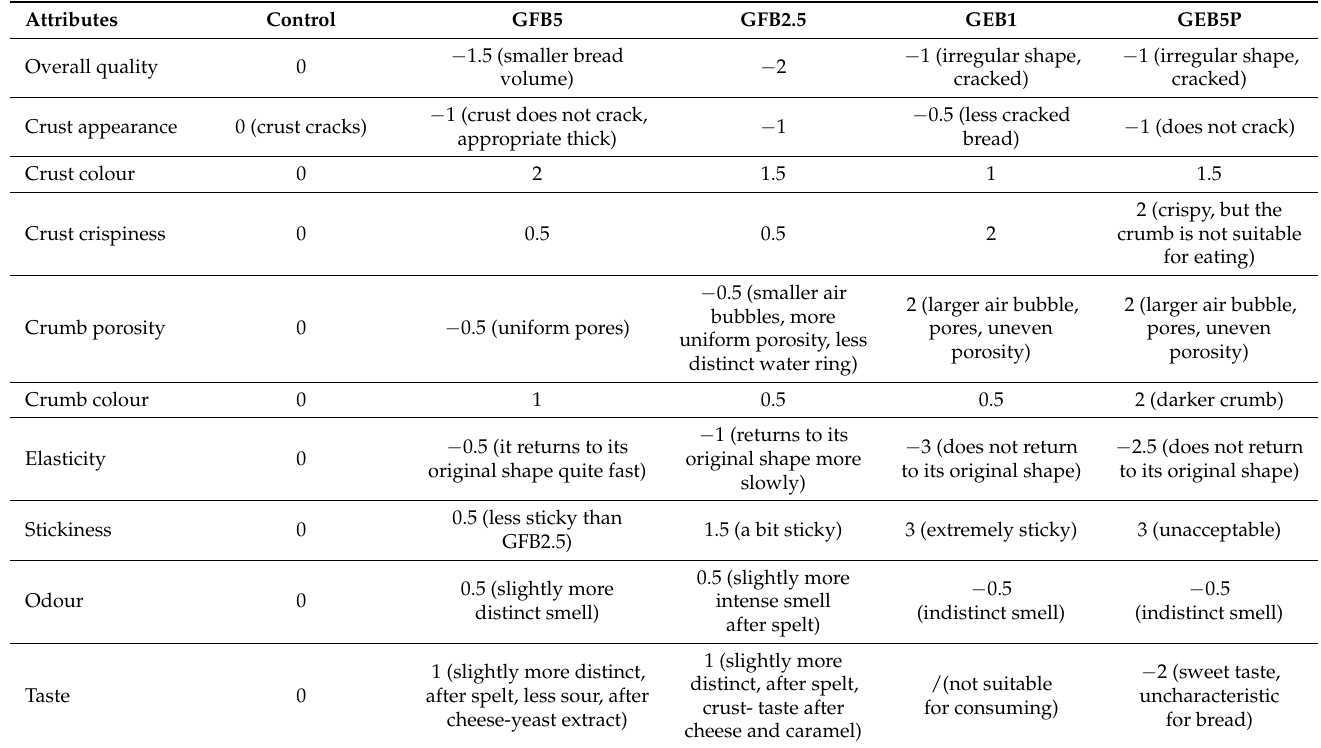
Table 3. Sensory attributes of bioprocessed breads, with the control bread serving as a basis for comparison, and the sensory attributes rated with scores from − 3 to